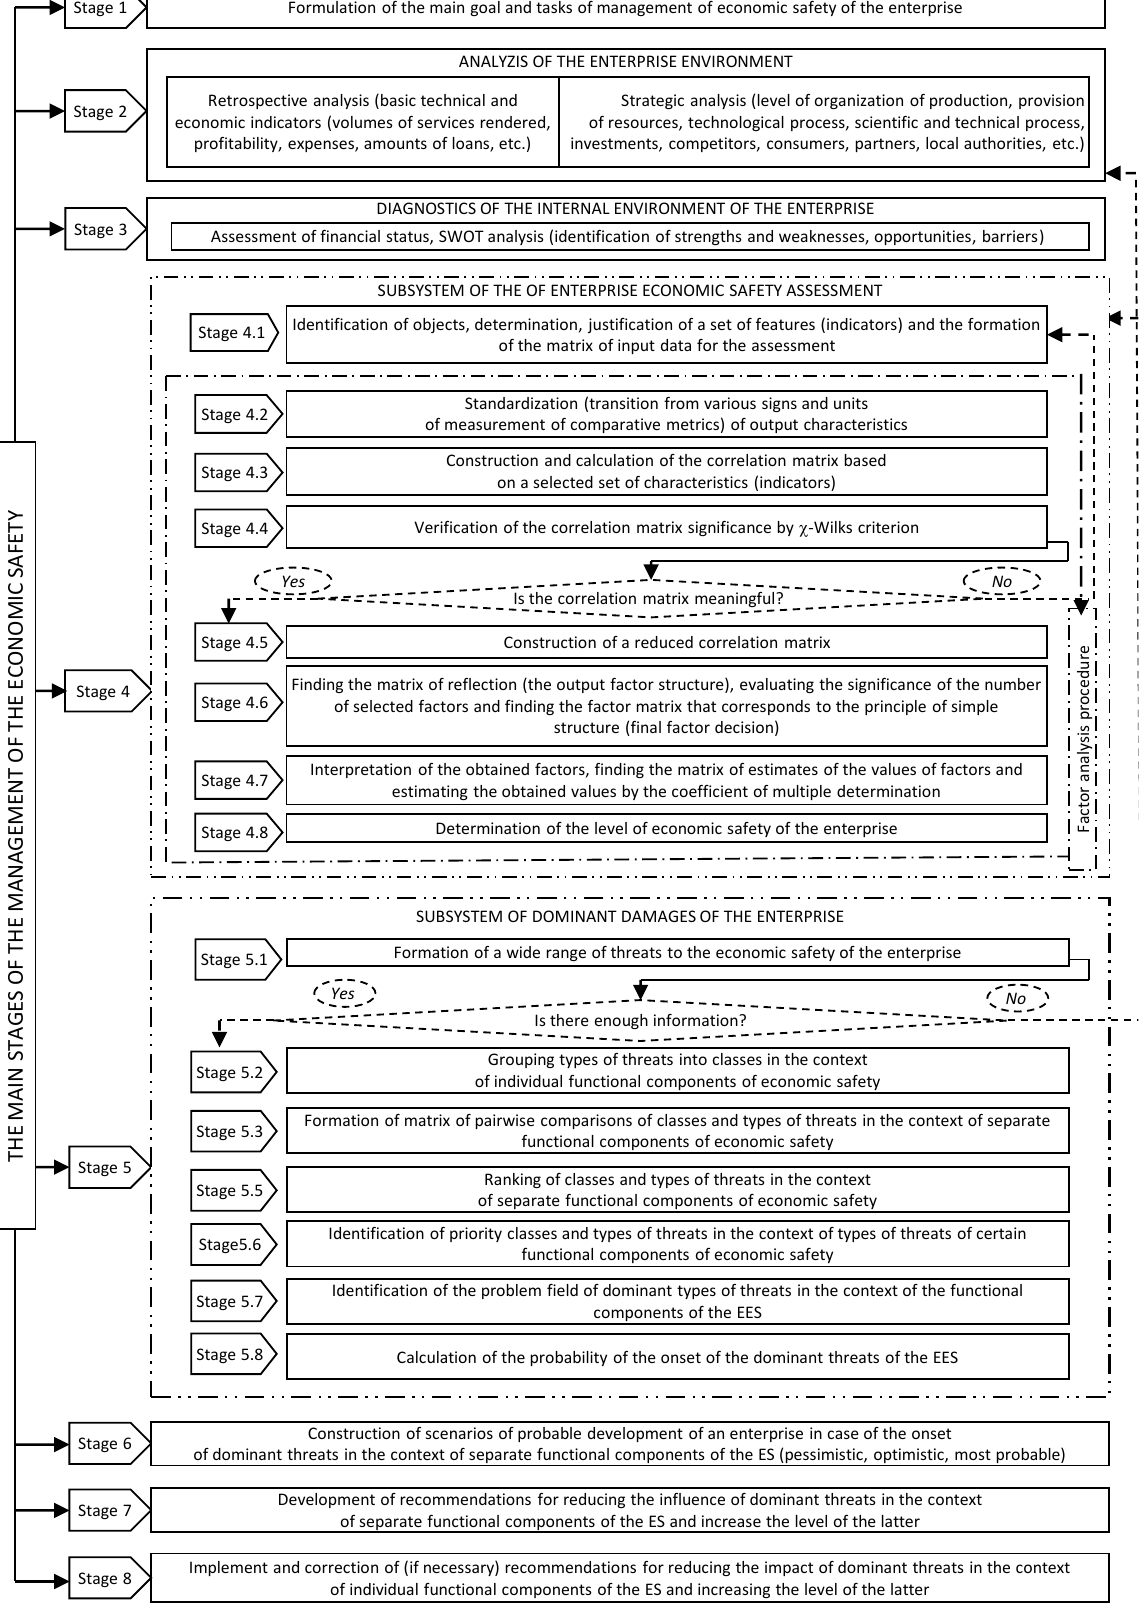
Figure 4. Principal diagram of the management process of the